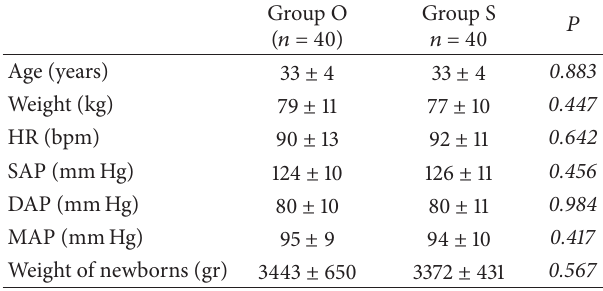
Table 1: Demographic